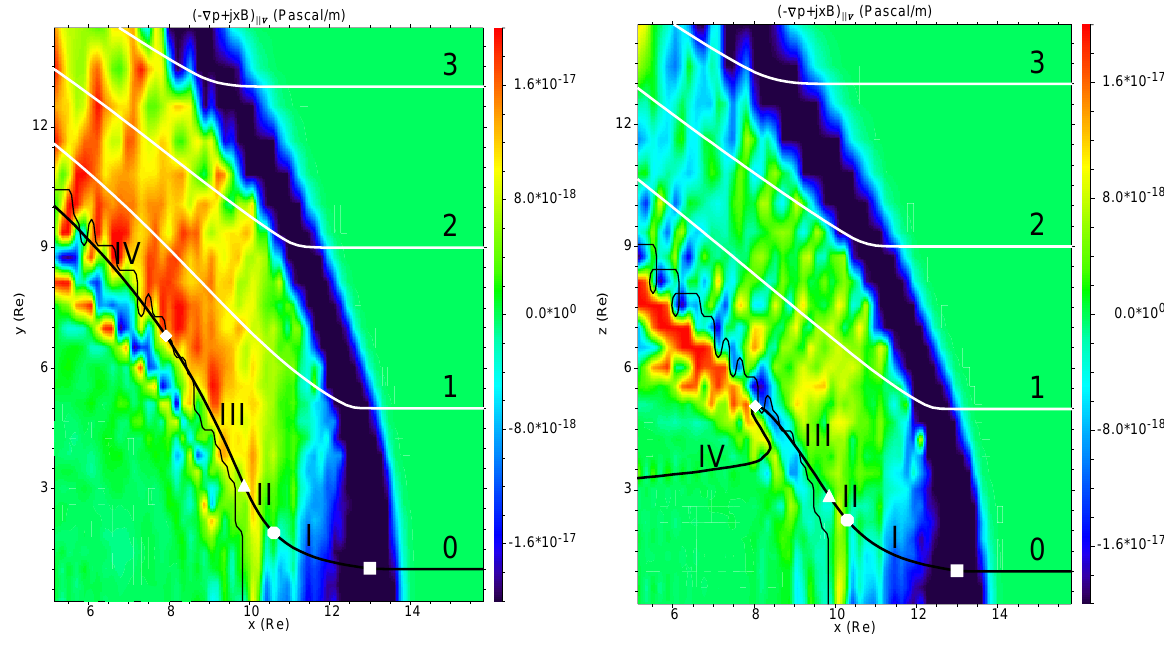
Fig. 8. The combined pressure gradient force and magnetic force along flow direction is shown color coded in the z =0 (left) and y =0 (right) planes. The open-closed magnetic field boundary is shown as a black zigzag curve and the streamlines are drawn with black and white thick smooth curves marked 0–3 in each of the panels. Regions I, II, III, and IV along streamline 0 have different force features. The white markers are the boundaries of those regions along streamline